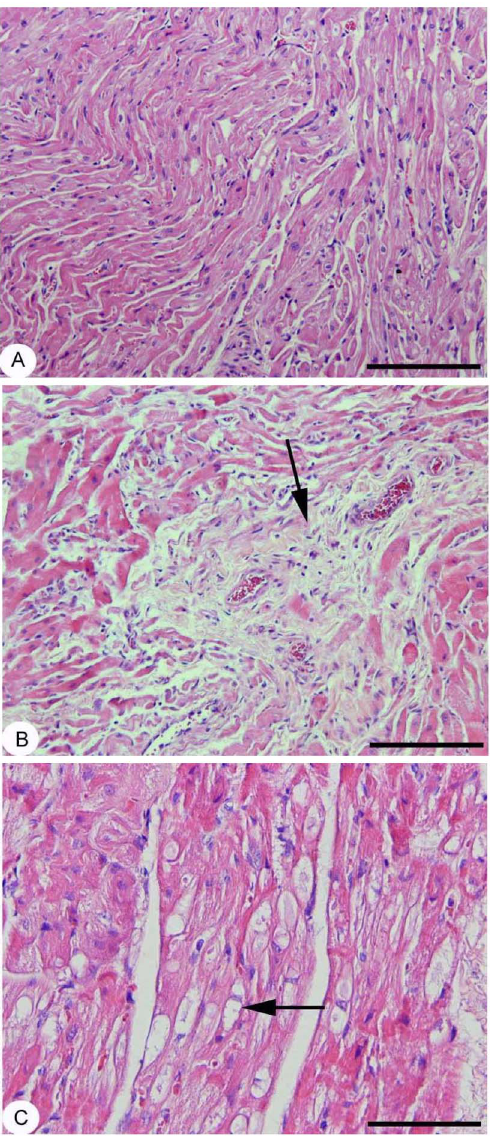
Figure 6. Atrial myocardial interstitial fibrosis. A: control heart section with no pathological interstitial collagen depositions; B: aged heart section with a focus of perivascular interstitial fibrosis (arrow); C: aged heart section with a focus of myocytolisis (arrow). Hematoxylin and Eosin staining. Original magnification: A and B 6 10, C 6 20 with scale bar in A and B 500 m m and in C 200 m m.